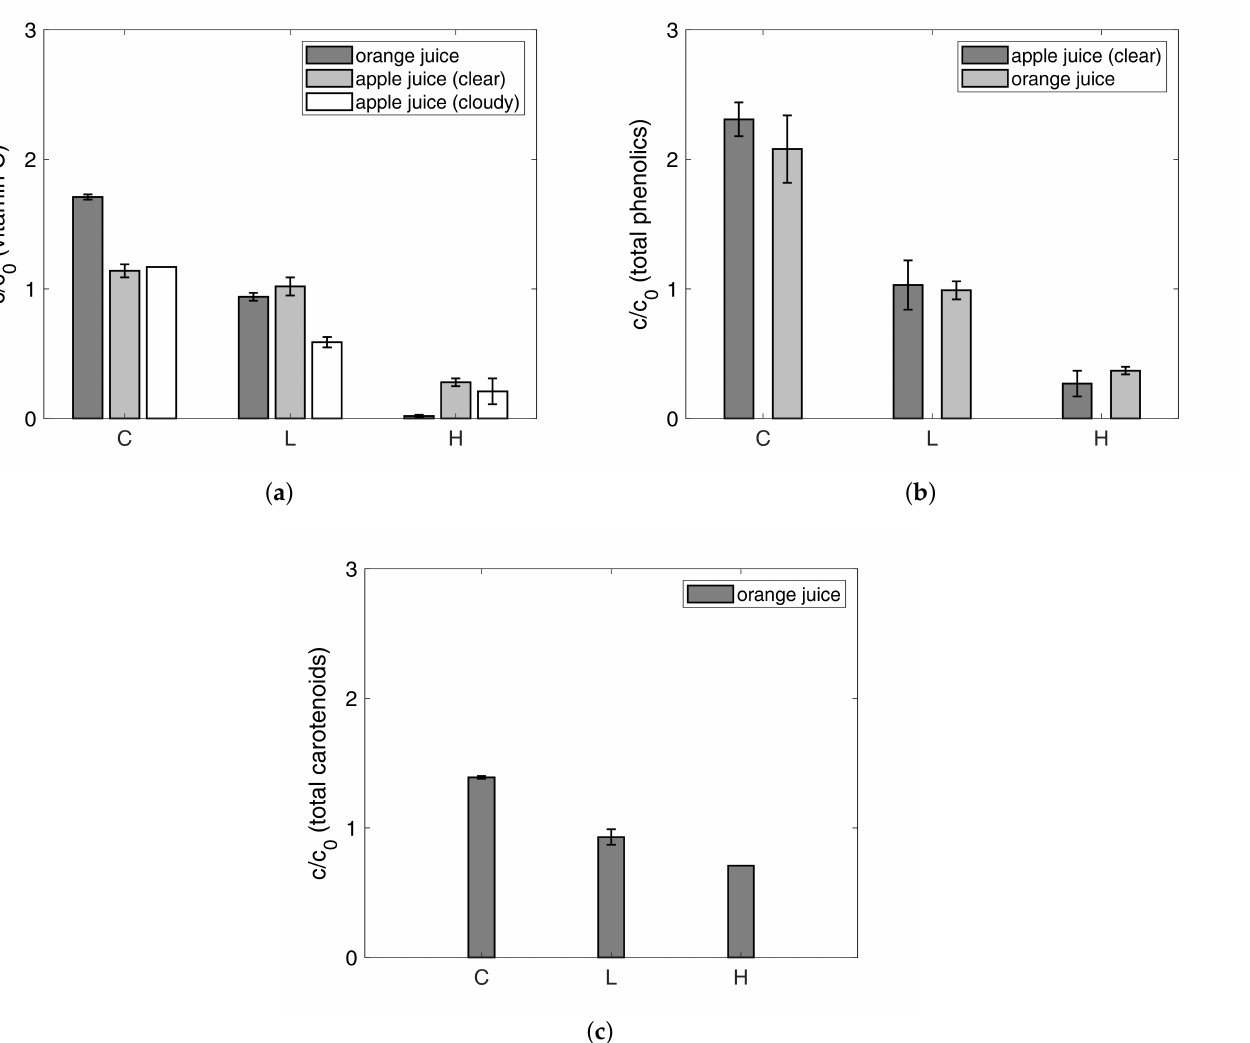
Figure 7. Quotients of the reached concentrations c produced and the corresponding initial concentrations c 0 for all phases from the concentration process: ( a ) vitamin C for orange juice, apple juice (clear) and apple juice (cloudy), ( b ) total phenolics for orange juice and apple juice (clear), and ( c ) total carotenoids for orange juice. C: concentrate, L: drained liquid from the hydrate, H: hydrate (error bars: standard error of the mean according to Section 2.9, the standard errors of the mean are given in Table